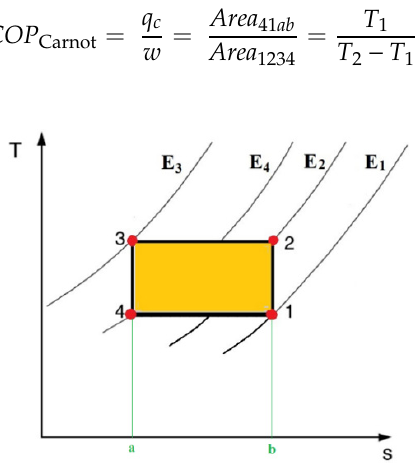
Figure 1. The four processes of the Carnot cycle for electrocaloric cooling.